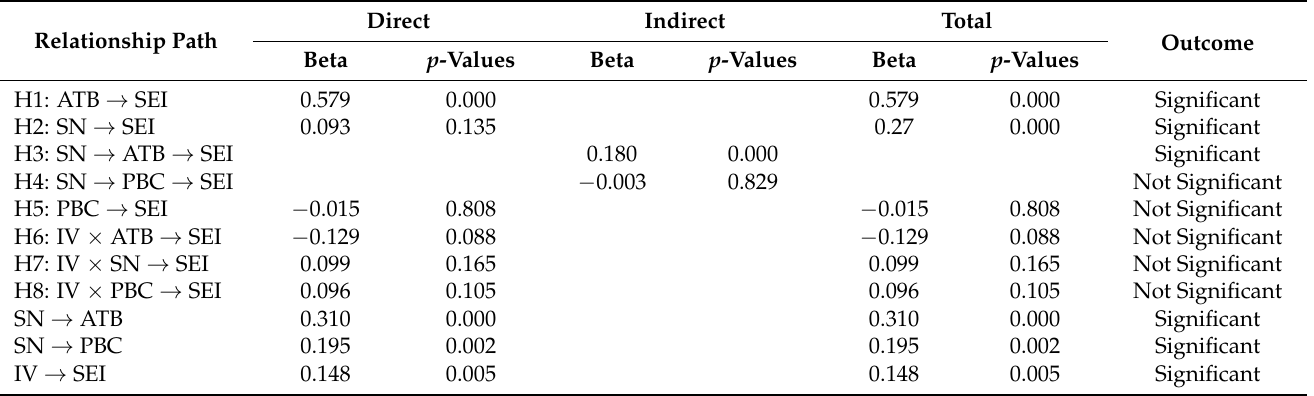
Table 8. Hypotheses test